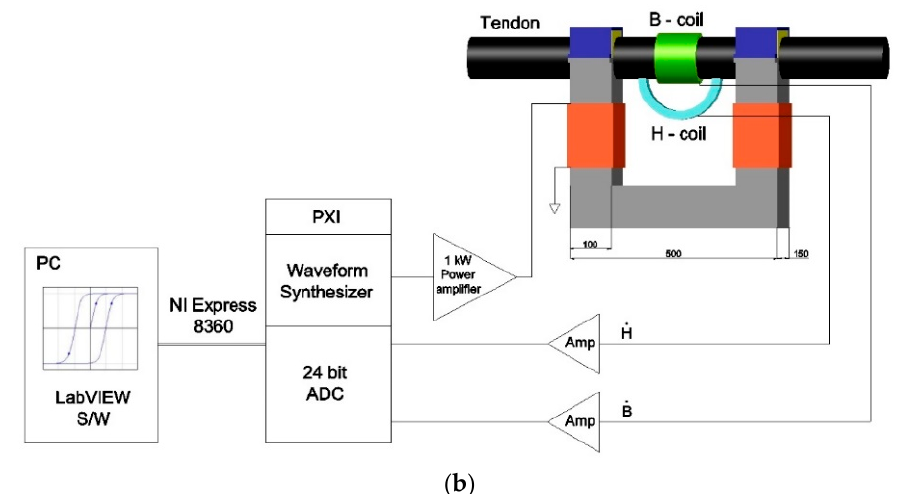
Figure 1. Non-contact movable yoke system: ( a ) Magnetic field leakage signal test setup with a damaged section; ( b ) Data acquisition system.